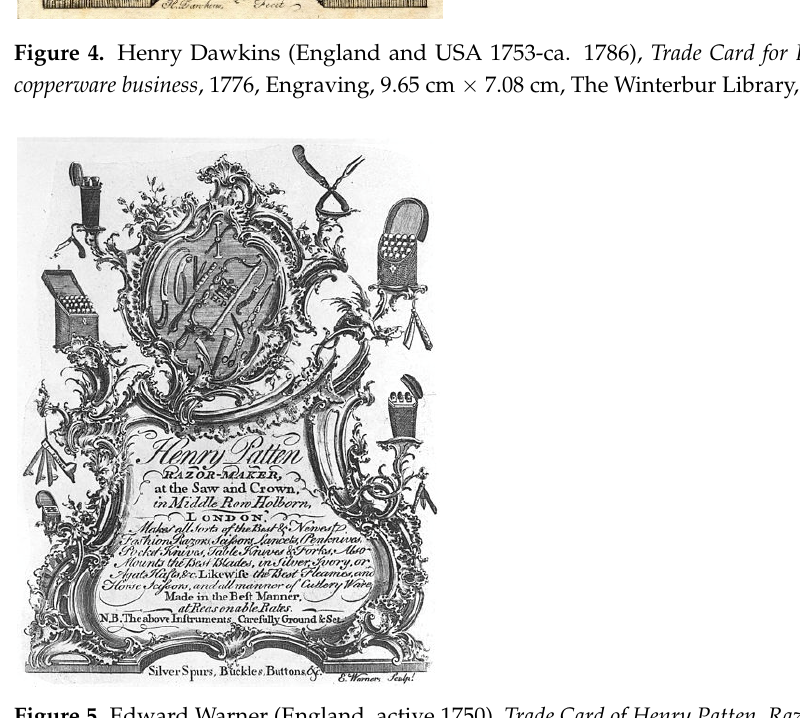
Figure 5. Edward Warner (England, active 1750), Trade Card of Henry Patten, Razor-Maker and Cutler , 1750 ca., Engraving, ink on paper, 19 cm × 14 cm, Victoria and albert Museum, London.